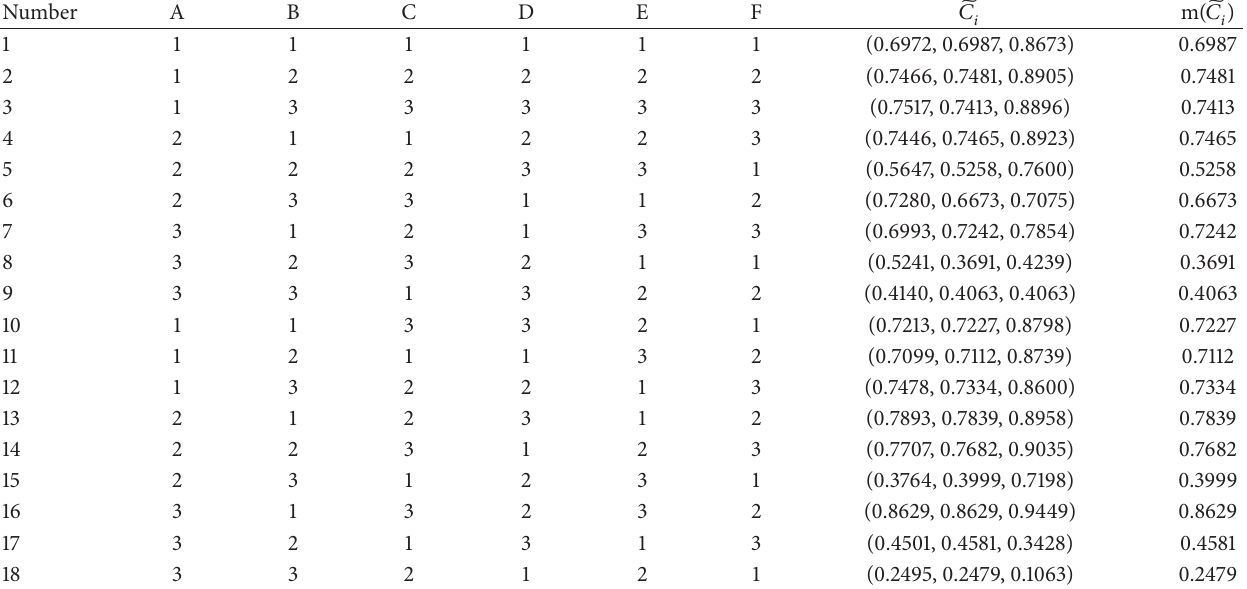
Table 5: Closeness coefficients for each combination of control